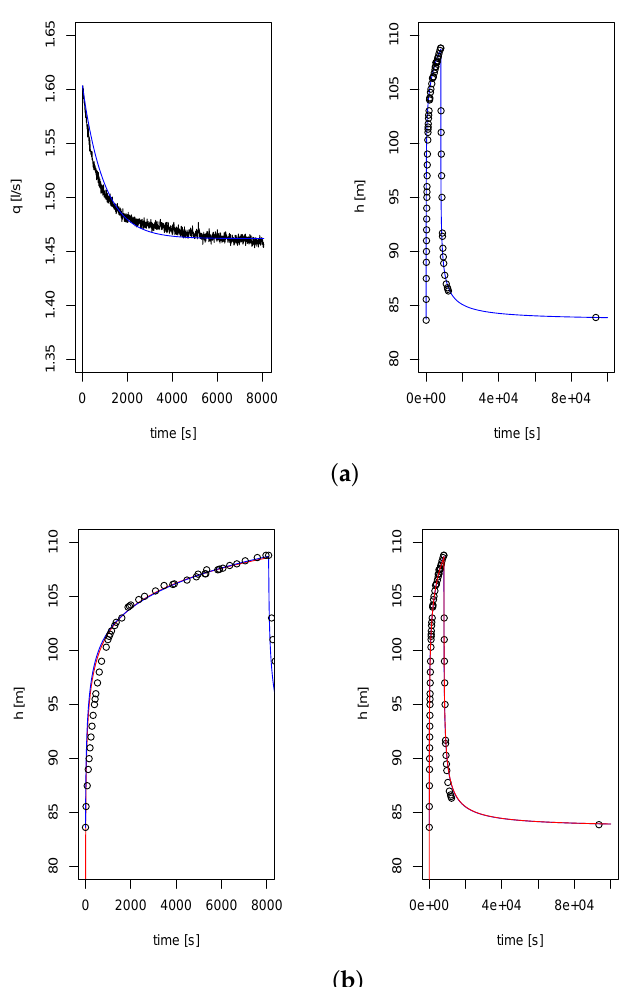
Figure 8. Calibration. ( a ) Left: Water flow evolution, measured (black) and adjusted (blue). Right: Water level evolution, measured (black) and simulated with the reference model and the 1st set of parameters (blue). ( b ) Water level measured (black) and simulated with the reference model (blue) and the simplified one (red), with the 2nd set of parameters. Left: Pumping period. Right: Pumping and recovery. The parameter related to water energy losses due to pipe transport is calibrated using the real power data, obtaining C q 2 = − 13.136 ms 2 /(dm 6 ). With all parameters adjusted, results of the simulations with both sets of parameters are presented in Figure 9. The estimated water levels H est are indicated in red color, overimpressed to the orange curves corresponding to H Pe . Measured data are plotted in black. Both results are in good agreement with data. The error diminishes with time, being less than 1% of H except during the first 10 to 15 min. Overestimation of first set of parameters is larger the second one during this starting